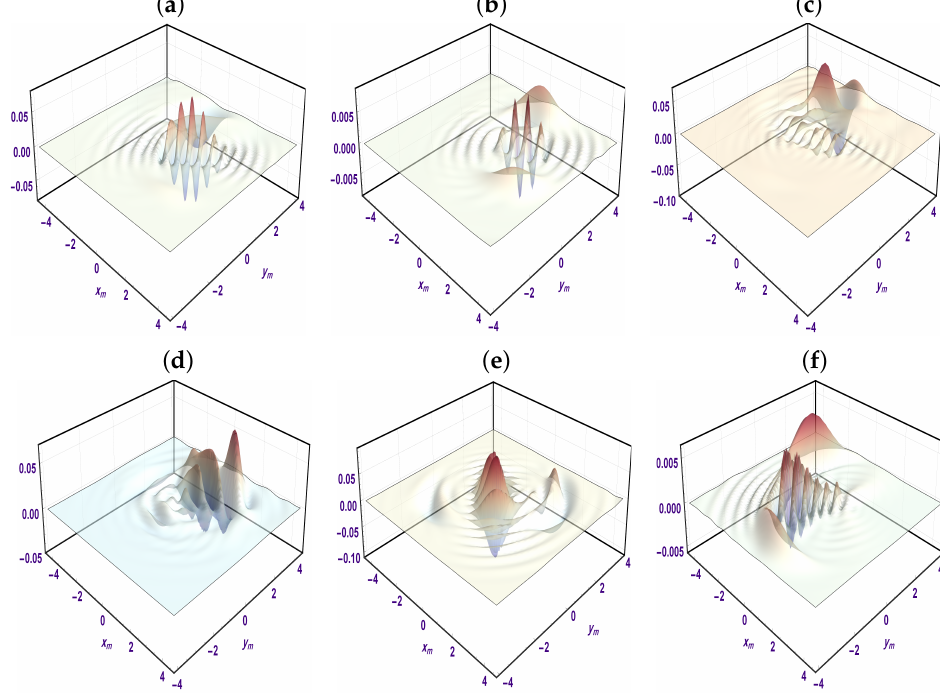
Figure 2. The behaviour of W as a function of x m , y m , where Γ c = 0.5 ( 1 + I ) , where ( a ) θ = 0, λ 1 = 1 = λ 2 = λ 3 ; ( b ) θ = π /4, λ 1 = 1 = λ 2 = λ 3 ; ( c ) θ = π /2, λ 1 = 1 = λ 2 = λ 3 ; ( d ) θ = π /4, λ 3 = 2, λ 1 = 1 = λ 2 ; ( e ) θ = π /4, λ 2 = 2, λ 1 = 1 = λ 3 ; ( f ) θ = π /4, λ 1 = 2, λ 2 = 1 = λ 3